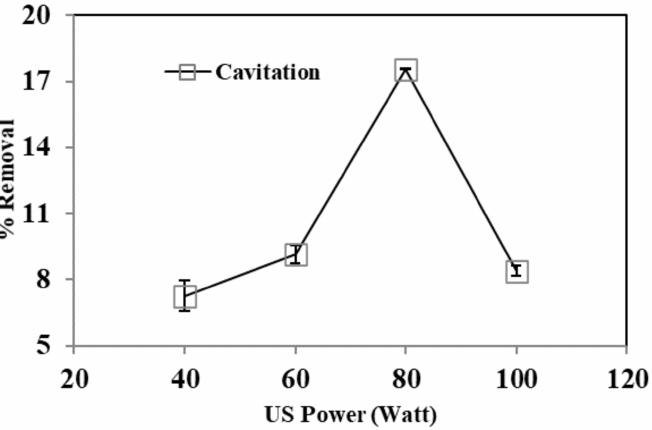
Figure 6. The effect of ultrasonic power on cavitation process. Experimental conditions: phenol conc. = 25 mg L − 1 , pH = 3.5, temperature = 30 ± 2 ◦ C, time = 60 min.